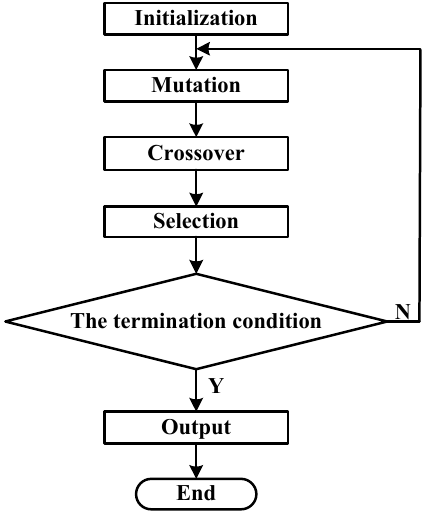
Figure 7. The principle of Differential Evolution algorithm.